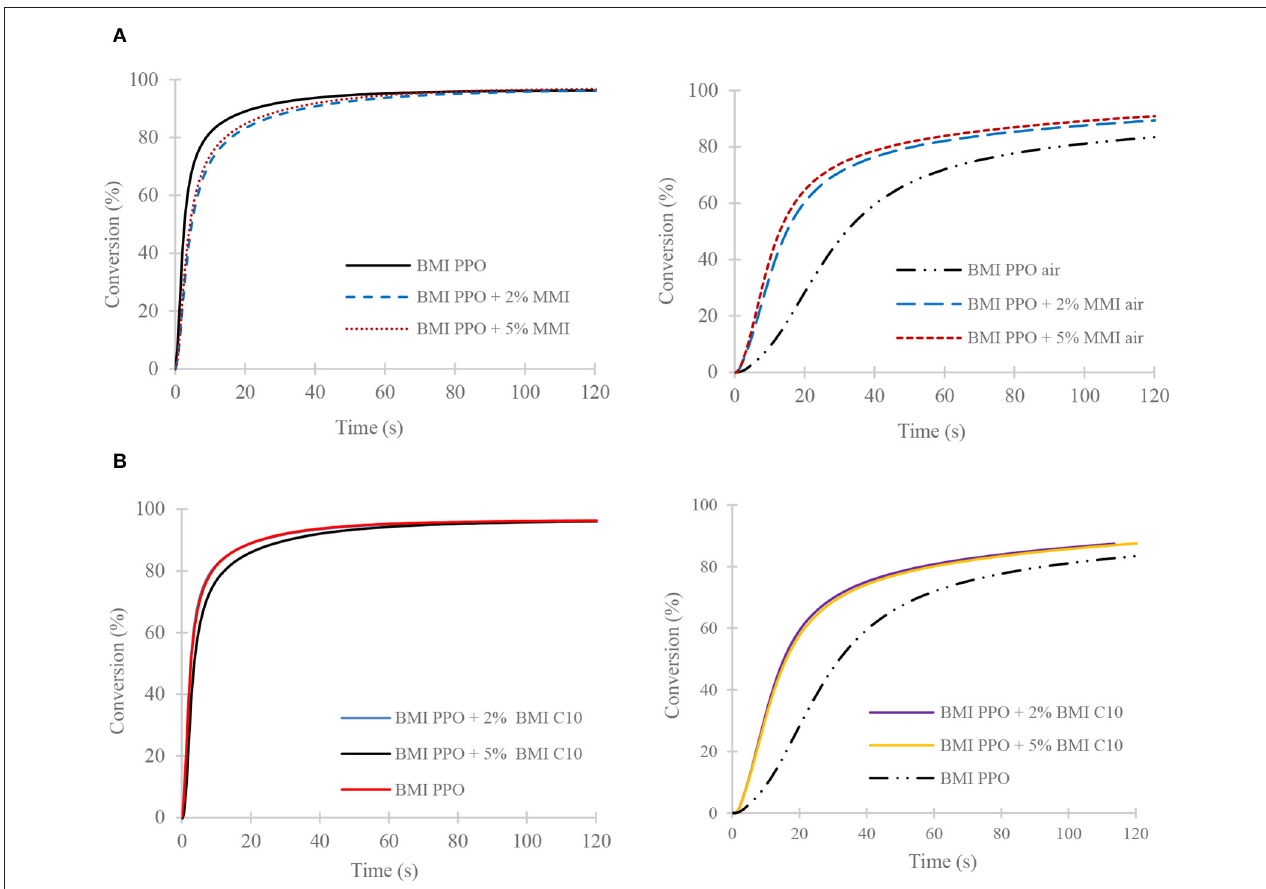
FIGURE 3 | (A) Photopolymerization conversion curves of BMI PPO with different amounts (wt%) of MMI in the absence (left) and presence (right) of air. (B) Photopolymerization conversion curves of BMI PPO with different amounts (wt%) of BMI C10 in the absence (left) and presence (right) of air.